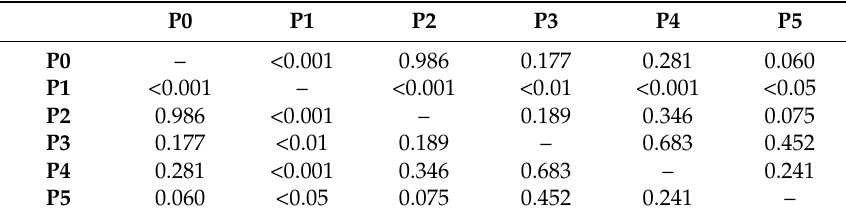
Table 3. p -Value between each period analysed for aerobic exercise.